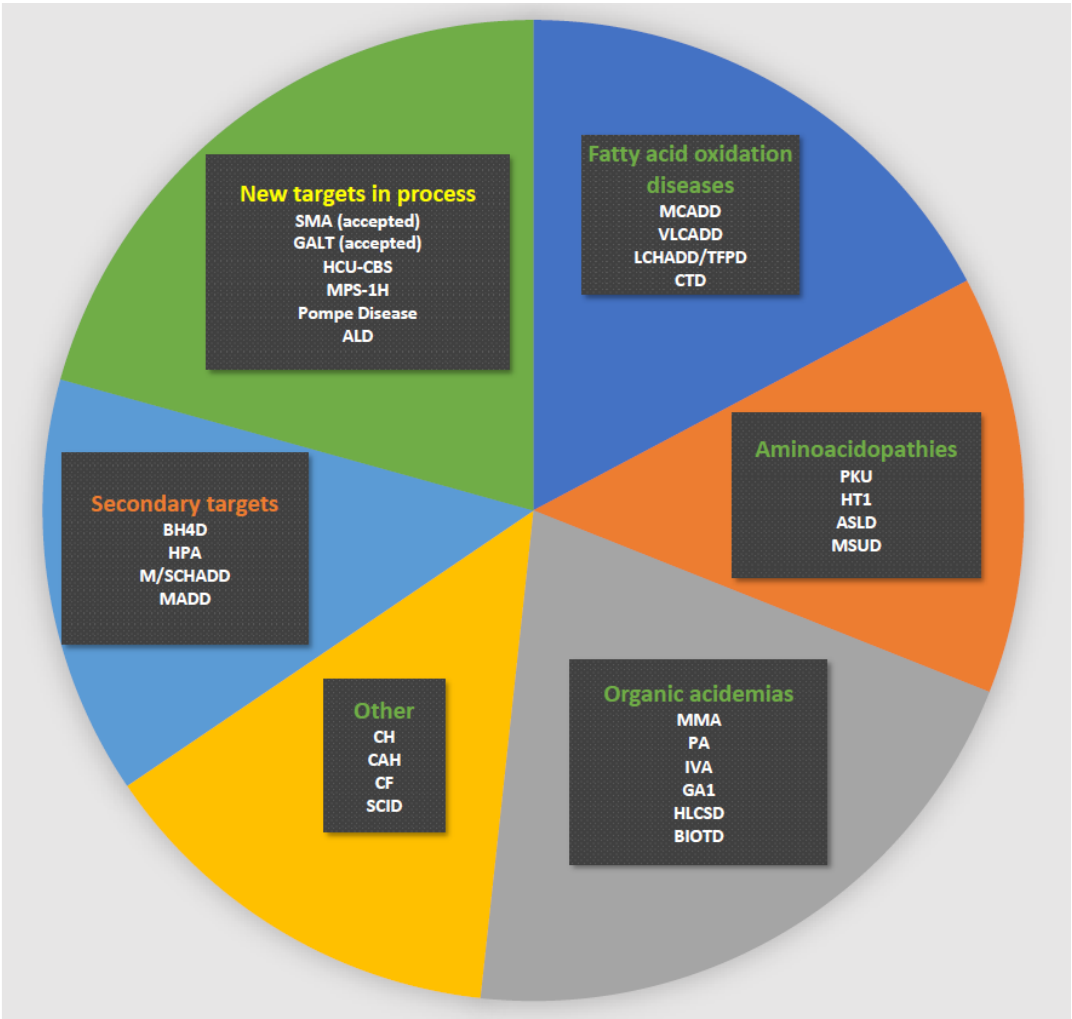
Figure 2. Current Danish newborn screening panel. Green heading: primary targets; orange heading: secondary targets; yellow heading: new targets in process for possible inclusion. Disease abbreviations are shown in the list of abbreviations.